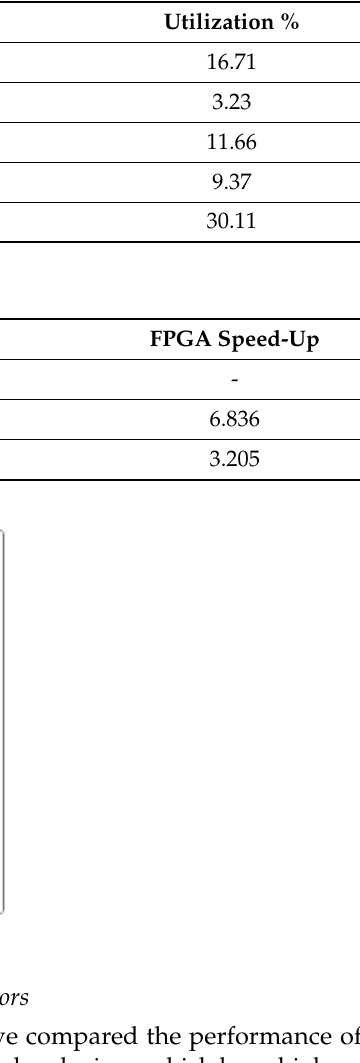
Table 1. Resource utilization.